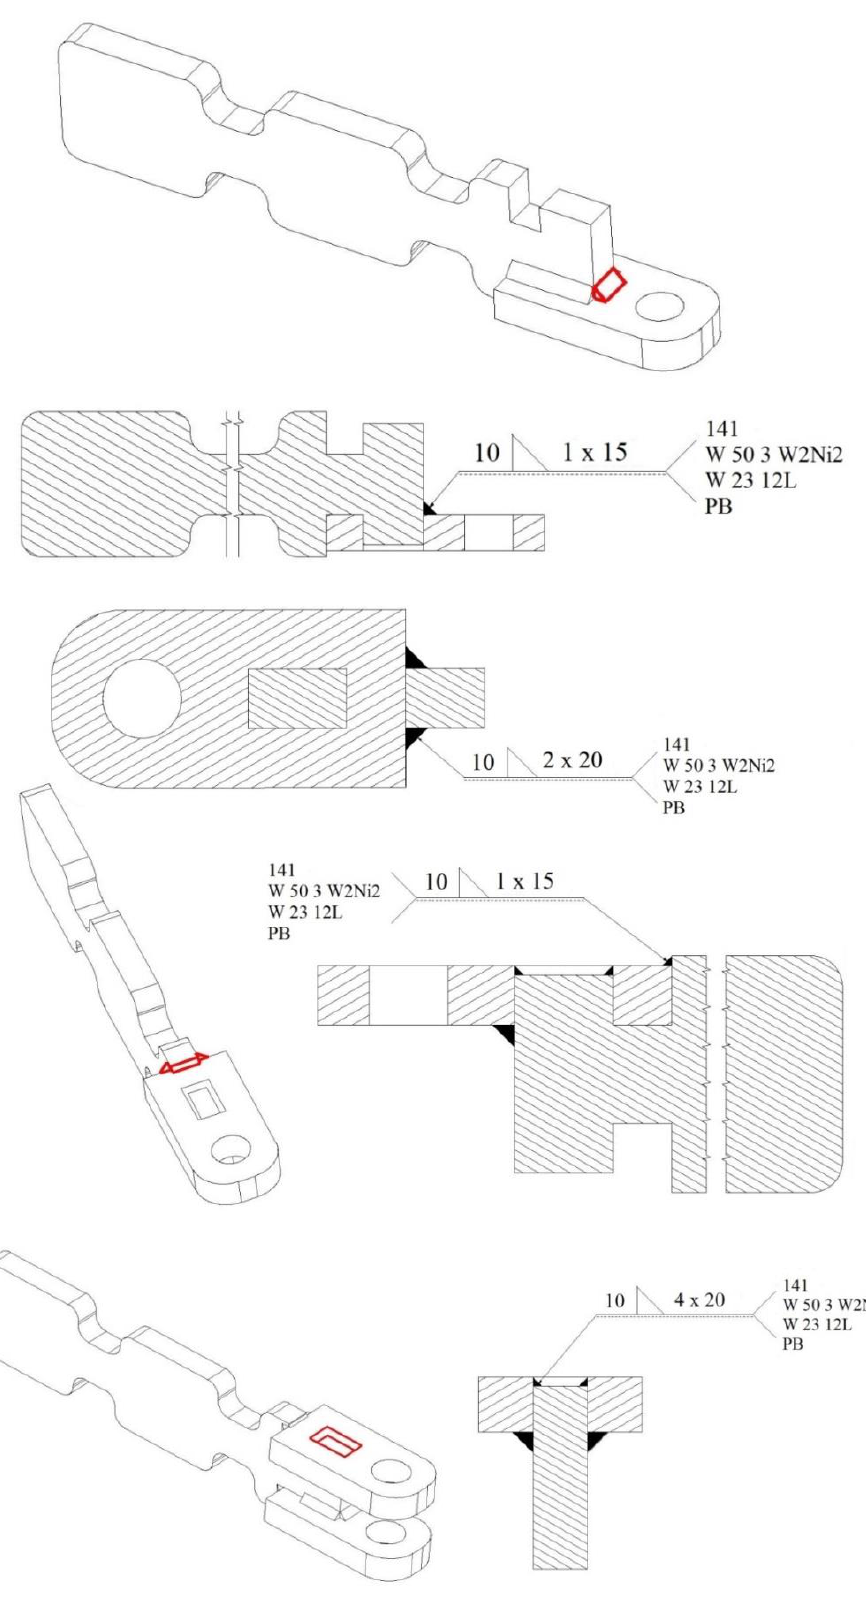
Figure 9. Weldment production procedure—basic dimensions of hammer attachment welds. Manual welding parameters of hammers are documented in Table 3. For welding Hardox 400 material, the manufacturer of filler materials ESAB recommends two types of